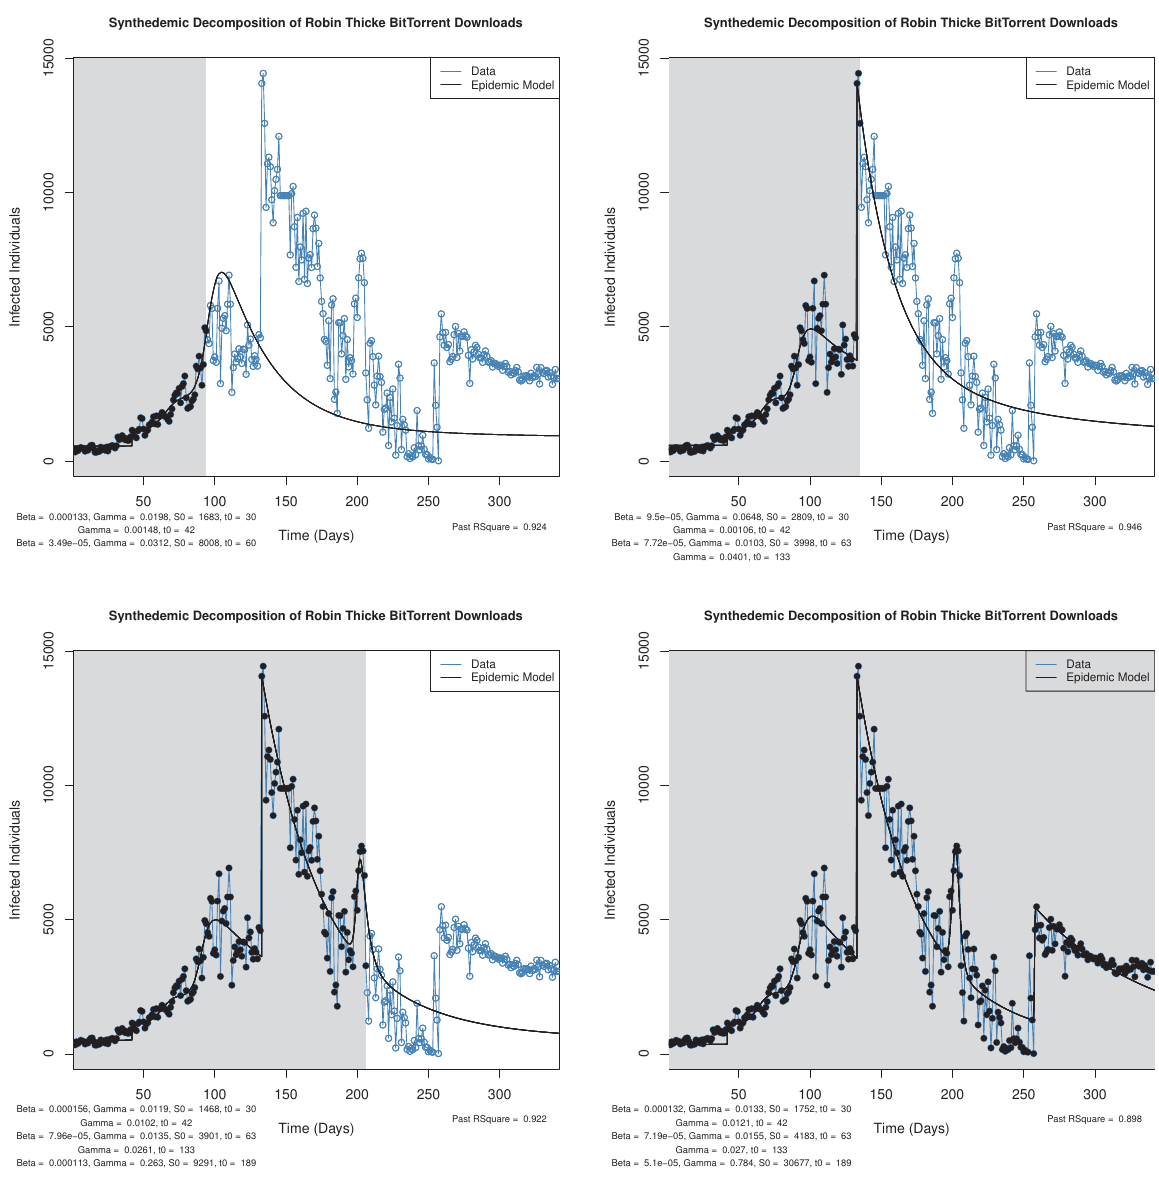
Figure 5: Synthedemic fit at days 94, 135, 206 and 342 to Robin Thicke’s BitTorrent downloads ( r 2 target = 0 . 9)